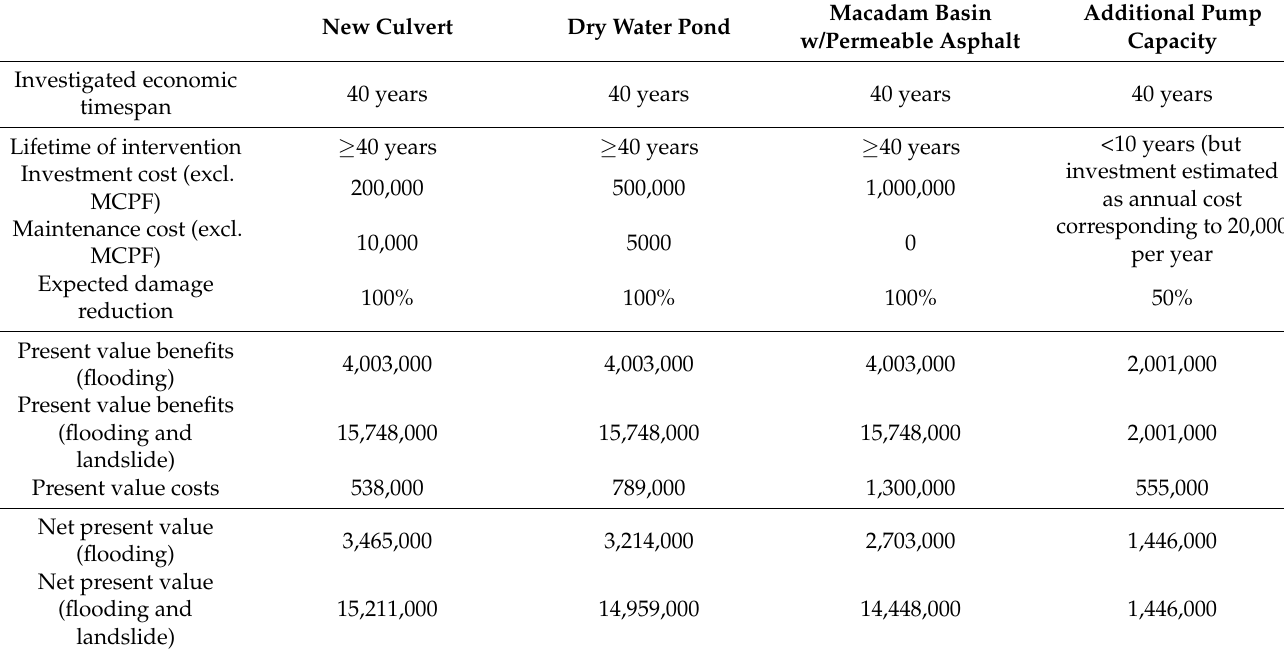
Table 2. Cost benefit inputs, present value of benefits and costs, and net present value of four measures, with increasing probability of flooding over time (100-year event to 10-year event), SEK in 2017-year prices. New Culvert Dry Water